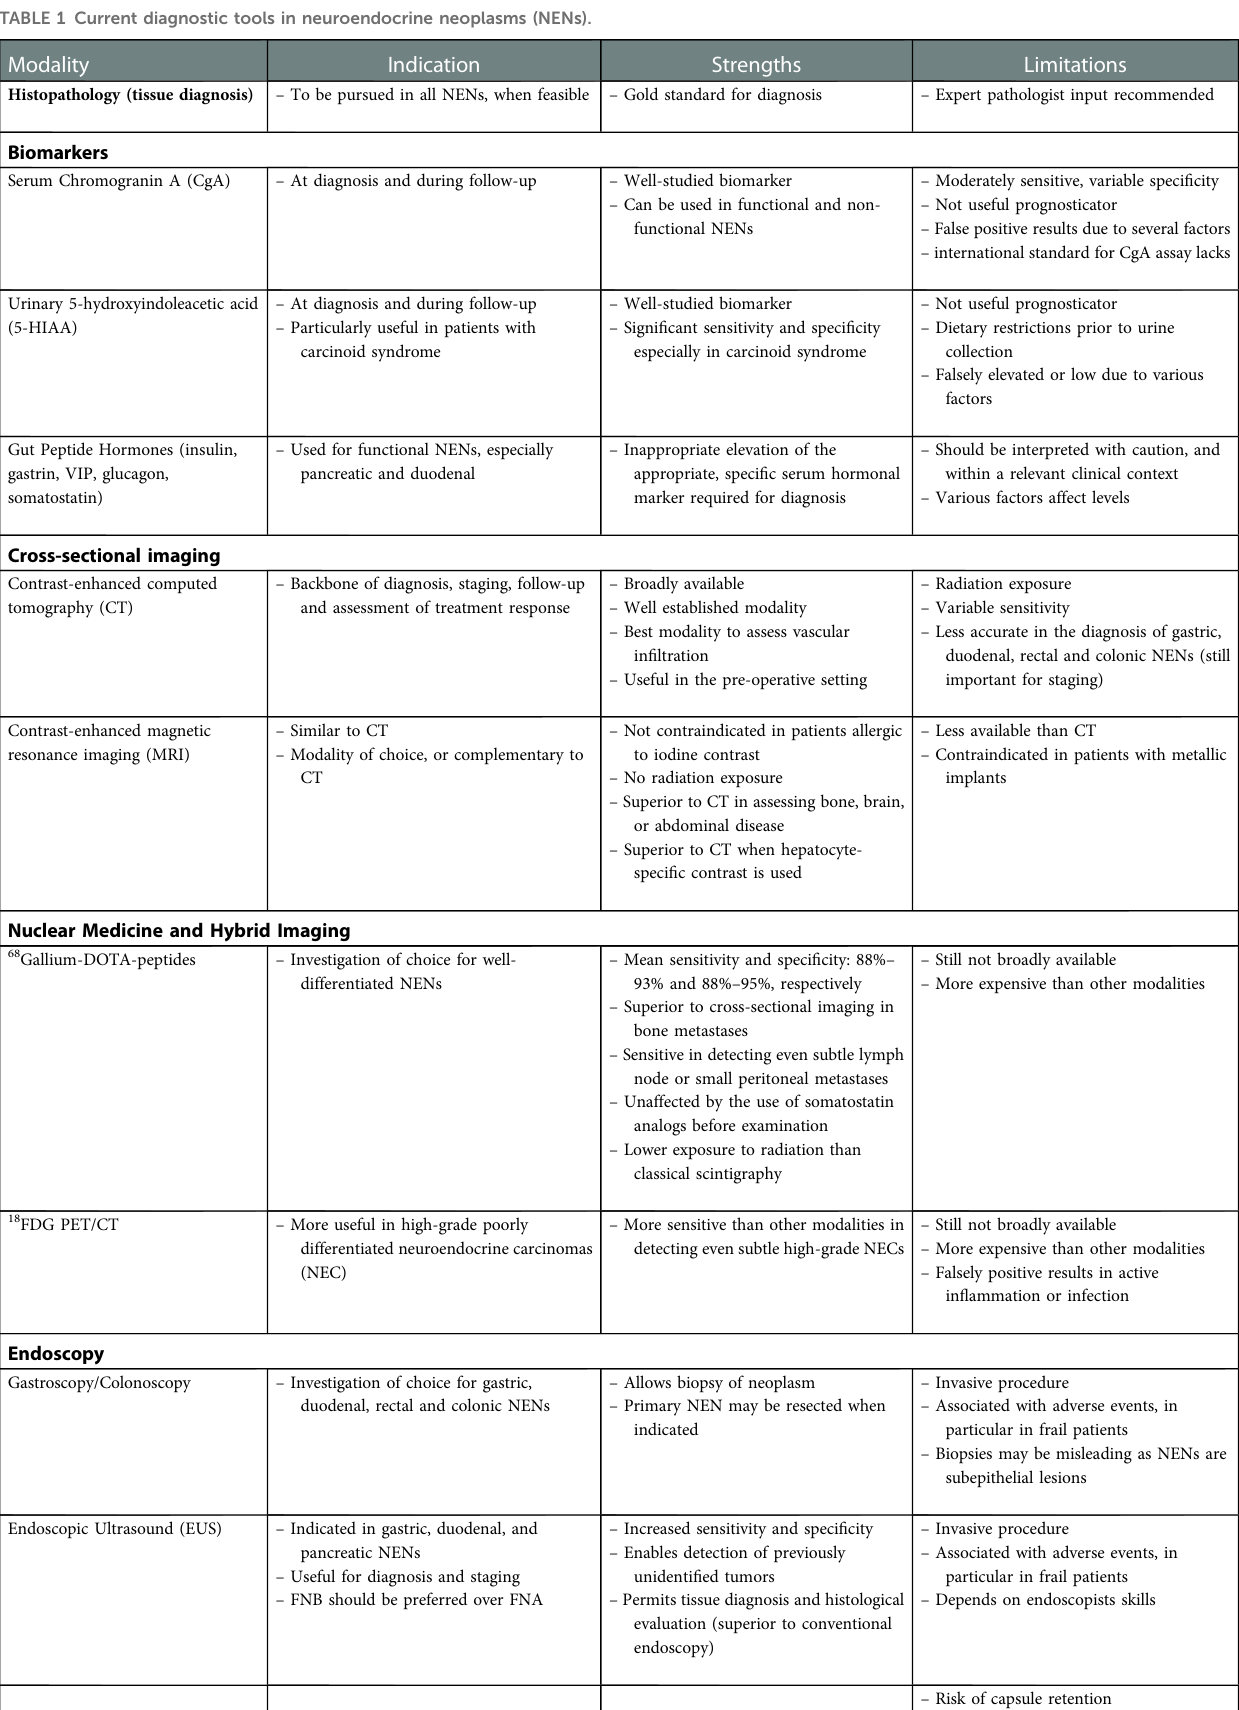
TABLE 1 Current diagnostic tools in neuroendocrine neoplasms